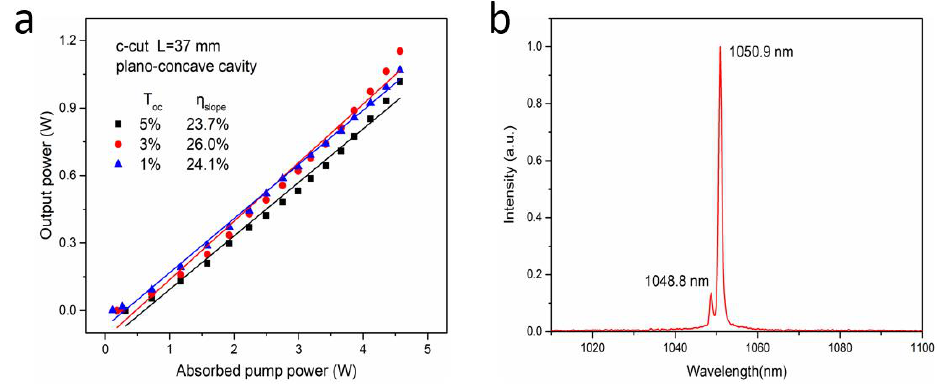
Figure 5. The output performance of Nd:ASL lasers with a laser cavity of 37 mm ( a ) and the laser spectra ( b ).